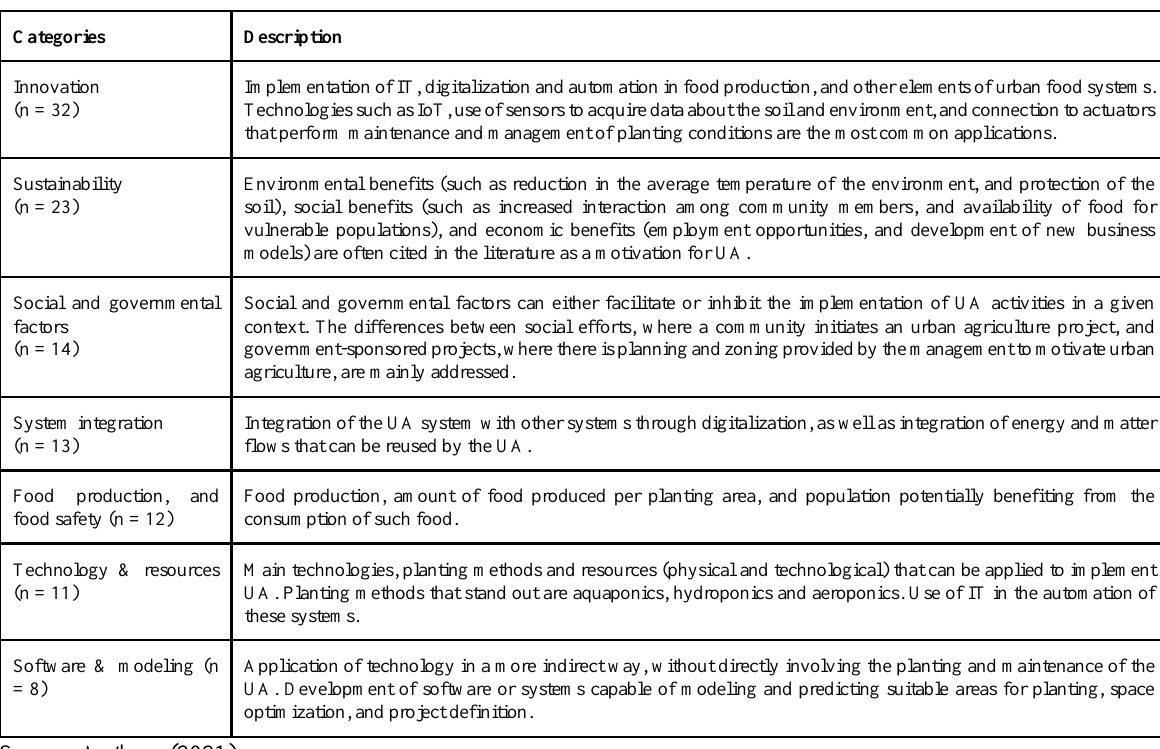
Table 2. Categorization according to the systematic literature